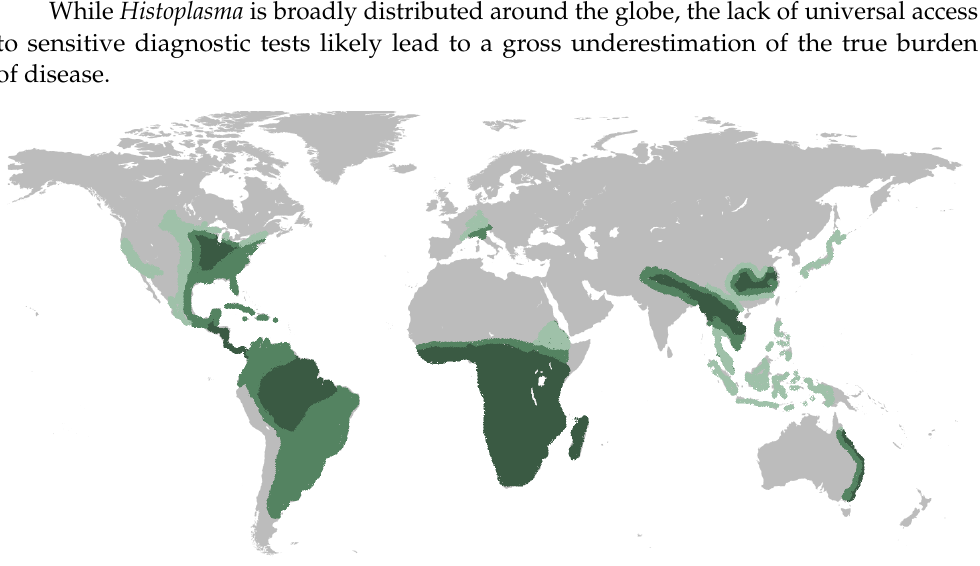
Figure 1. World map epidemiology of Histoplasmosis. Dark green represents areas likely to be hyperendemic, green represents areas where infection occurs regularly. Light green represents areas where local infections have been reported.